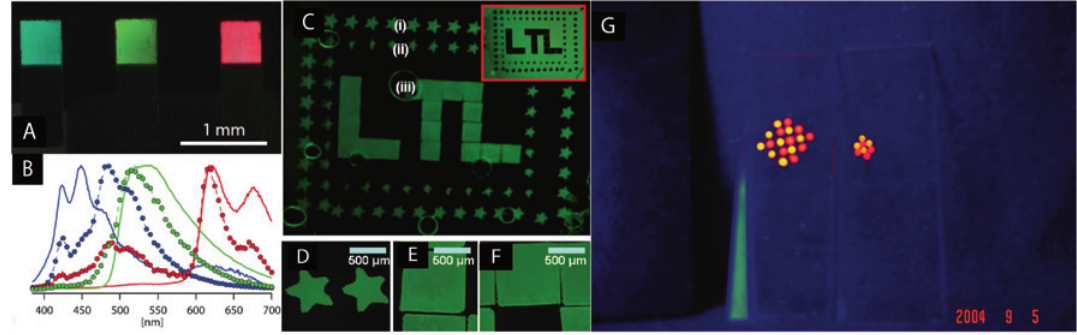
Figure 6: LIT of light emitting diode material. (A – B) Tri-color pixels imaged in a light microscope (A) and corresponding electroluminescence spectra (B) of the laser-printed pixels (dashed lines with circular markers) and conventionally fabricated devices (solid lines). Reprinted with permission from Ref. [80]. (C – F) Fluorescent images of Alq 3 transferred using LIFT with masks to vary the pattern shape. Reprinted with permission from Ref. [66]. (G) Image of 6 × 6 matrix of alternating nanocrystal quantum dots under UV illumination. Reprinted with permission from Ref. [81].